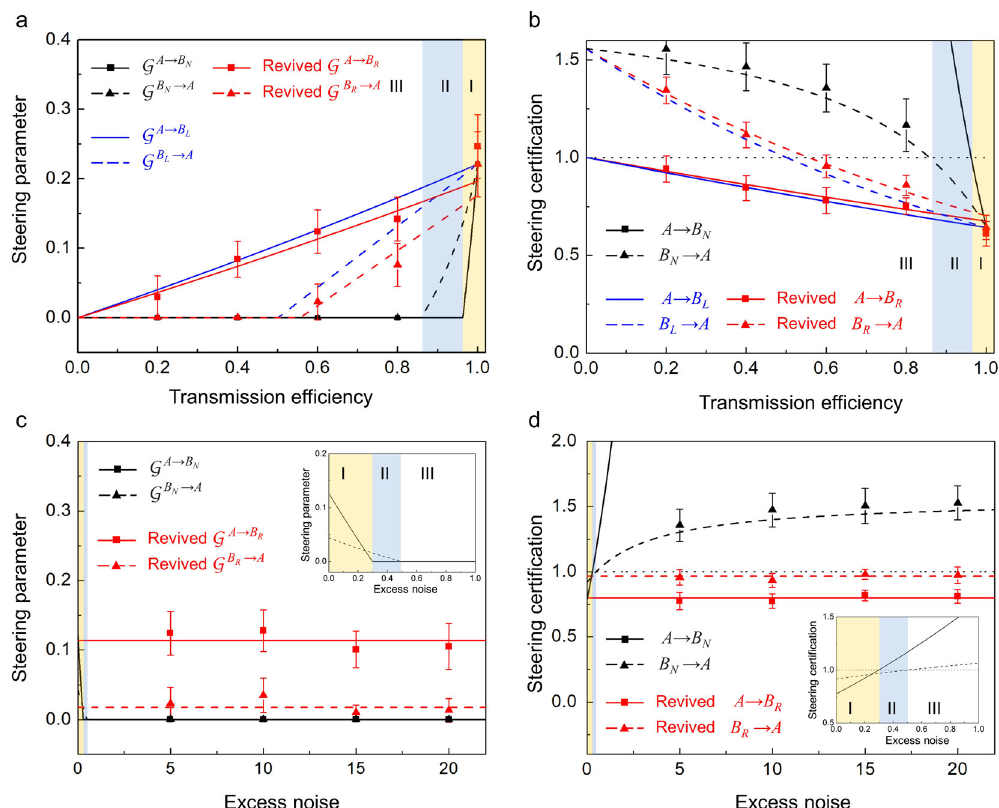
Fig. 3 Disappearance and revival of EPR steering in noisy channel. a , b Steering parameters quanti fi ed by Eqs. (4) and (5) in a noisy channel where the variance of the excess noise is taken as fi ve times of vacuum noise, respectively. Black dash and solid curves are the theoretical predictions of G B N ! A and G A ! B N , respectively. Region I, two-way steering; region II, one-way steering; region III, no steering. Red dash and solid curves are the theoretical predictions of G B R ! A and G A ! B R after steering revival, respectively. The blue dash and solid curves are the